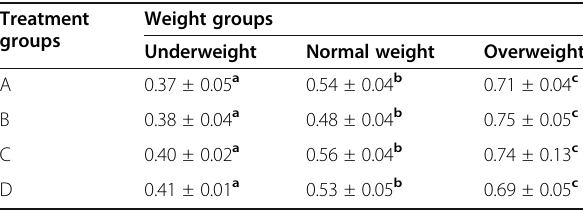
Table 1 BMI of rats by weight group and LPS treatment group (mean ±